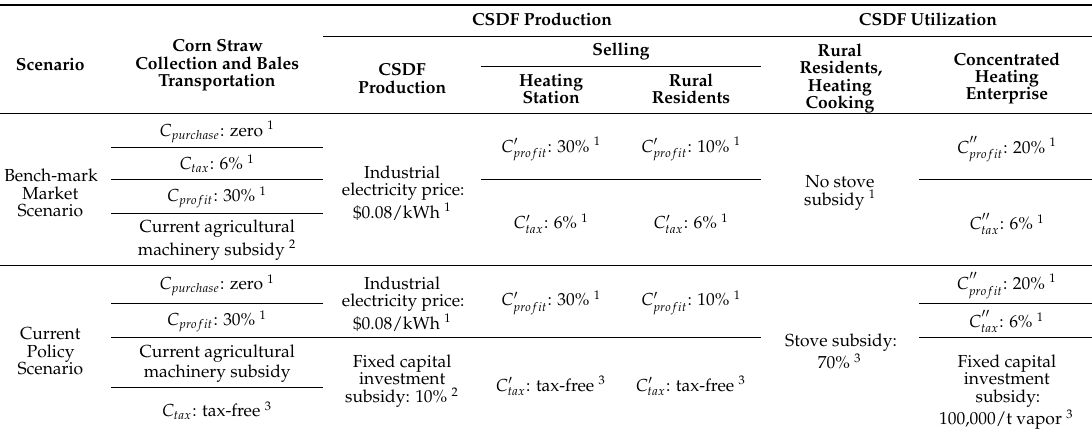
Table 5. Basic settings of the two policy scenarios by stages of a